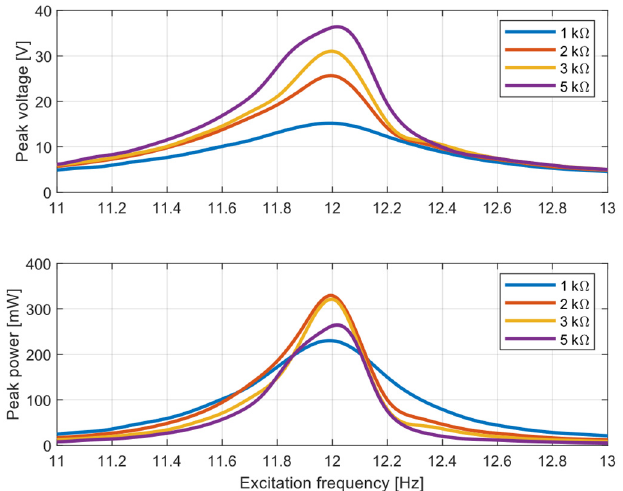
Figure 8. Voltage and output power depending on excitation frequency with different load resistance. Video S1.